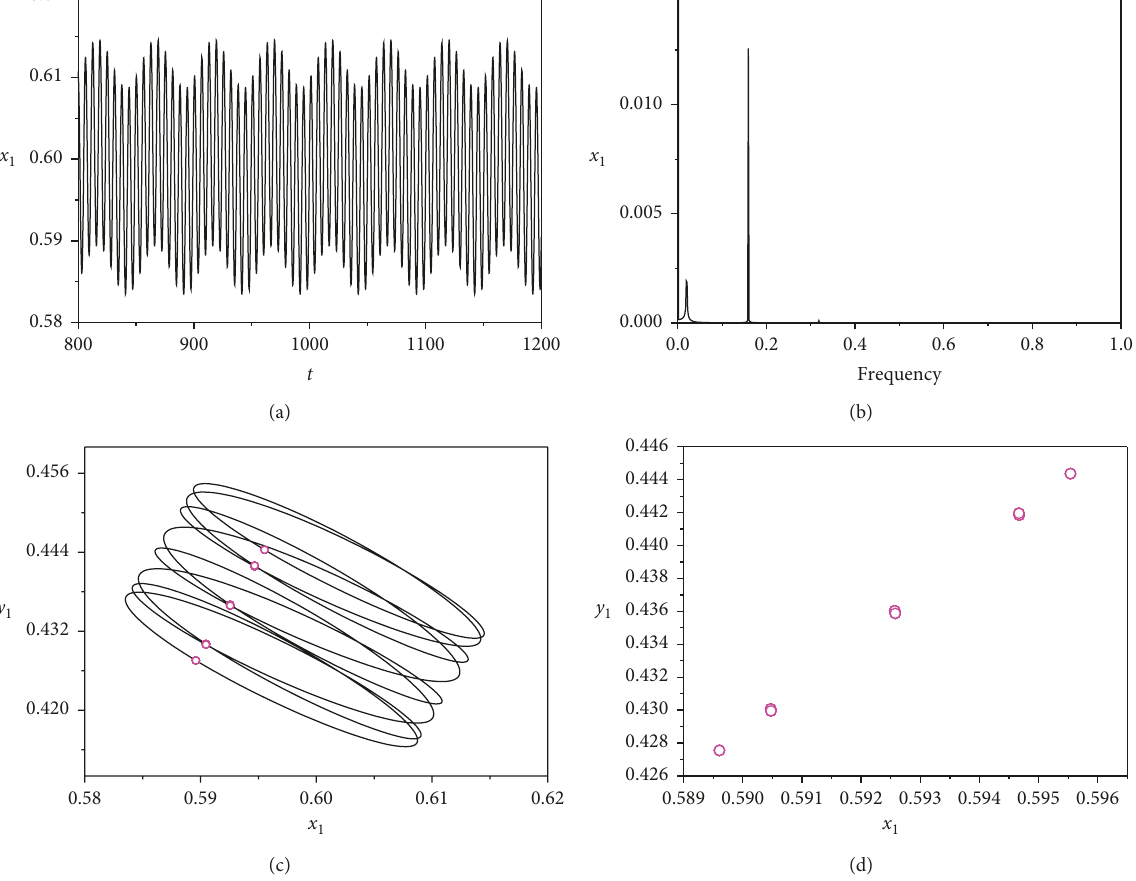
Figure 21: ω � 2.20 and ϕ � 0.075: (a) displacement response; (b) frequency spectrum; (c) rotor orbit; (d) Poincar´e